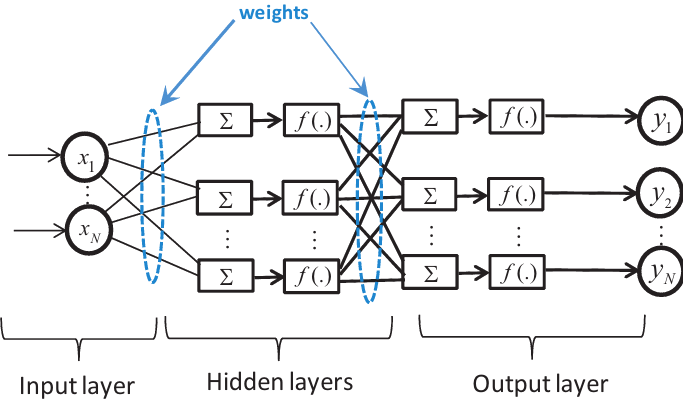
Figure 6. Layout of a multilayer